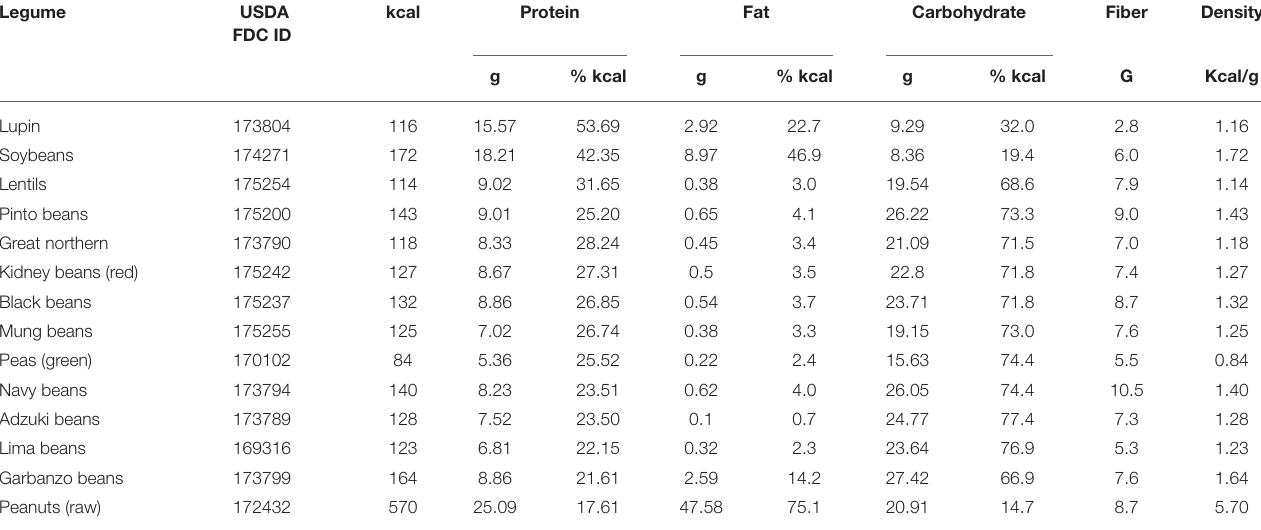
TABLE 1 | Macronutrient, caloric and fiber content per 100g of legumes (boiled unless otherwise indicated) according to the USDA nutrient database. Legume